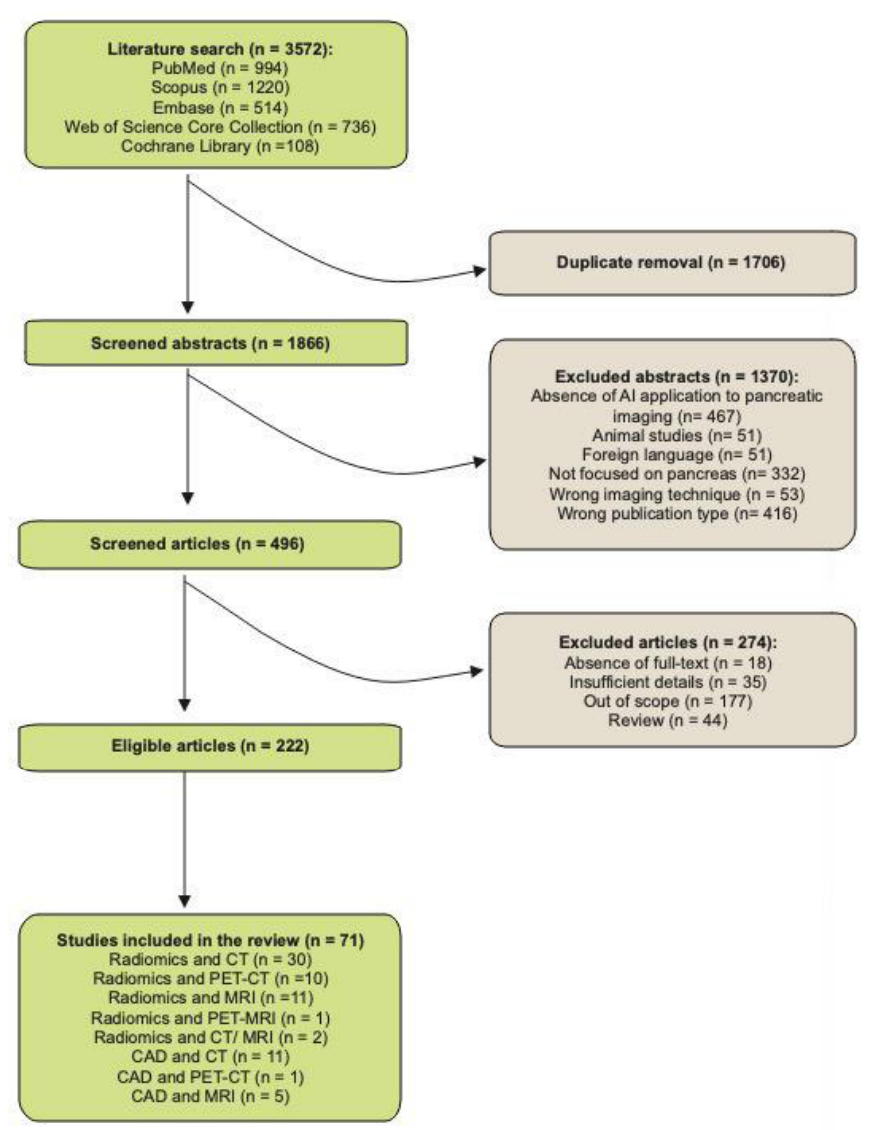
Figure 1. Flowchart of the study inclusion process.